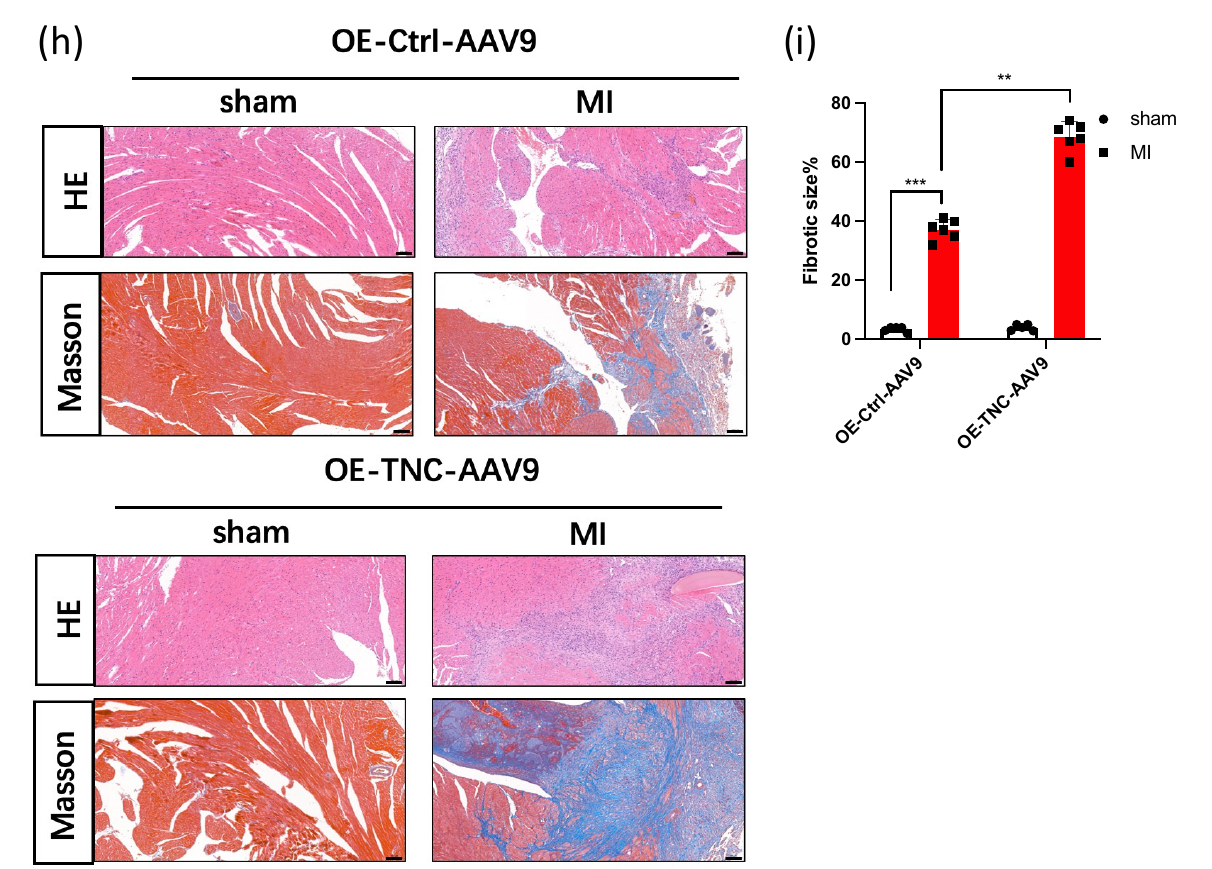
Figure 1. Overexpression of TNC leads to cardiac dysfunction and cardiac fibrosis. ( a , b ). Cell death in tissue samples was characterized by TUNEL assay, scar bar: 50 um, ( n = 6); ( c – g ). Representative photographs of M-mode echocardiography. Quantitative analysis of echocardiography. FS, fractional shortening; EF, ejection fraction; LVIDd, left ventricular internal diameter end-diastolic: suggests that the size of the left ventricle is usually related to the impairment of cardiac function; LVIDs, left ventricular internal diameter end-systolic: reflects the size of the ventricle at the end of cardiac contraction ( n = 6); ( h ) Masson Trichrome staining and HE staining of heart tissue sections 28 days post-ligation, scar bar: 100 um, ( n = 6); ( i ) statistical analysis of the fibrosis in Figure 1h ( n = 6). ** p < 0.01, *** p < 0.001.